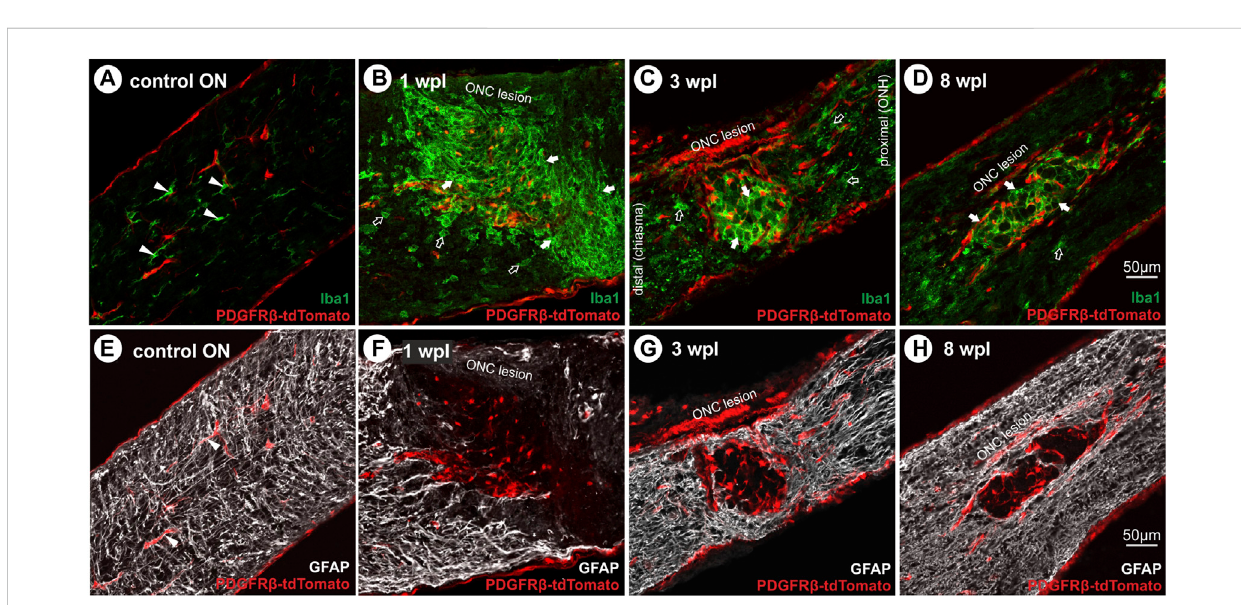
FIGURE 5 Microglial cell activationand absence of GFAP + fi lamentsin the lesionover time. (A) In the control ON, Iba1 + microglial cells (green) display a rami fi ed form with motile processes, lacking tdTomato expression. Following ONC, microglial cells become activated and reveal an amoeboid form organized in a grit-like pattern at (B) 1 wpl, (C) 3 wpl, and (D) 8 wpl withinthe lesioned area(green). Furthermore, activatedcells are detected distal andproximal to the lesion. (E) Inthe controlON,GFAP + fi lamentsofastrocytesarehomogenouslydistributed(white),interactingwithvascularcells via theirendfeet.FollowingONC,thelesion areaisdevoidofGFAP + fi lamentsat (F) 1wpland (G) 3wpl.SinglerepopulatingGFAP + fi lamentscanbedetected (H) 8wpl.Filledarrowheadsrepresentmicroglial or astroglial cells, fi lled arrows mark activated microglial cells in the lesion, and open arrows mark those outside the